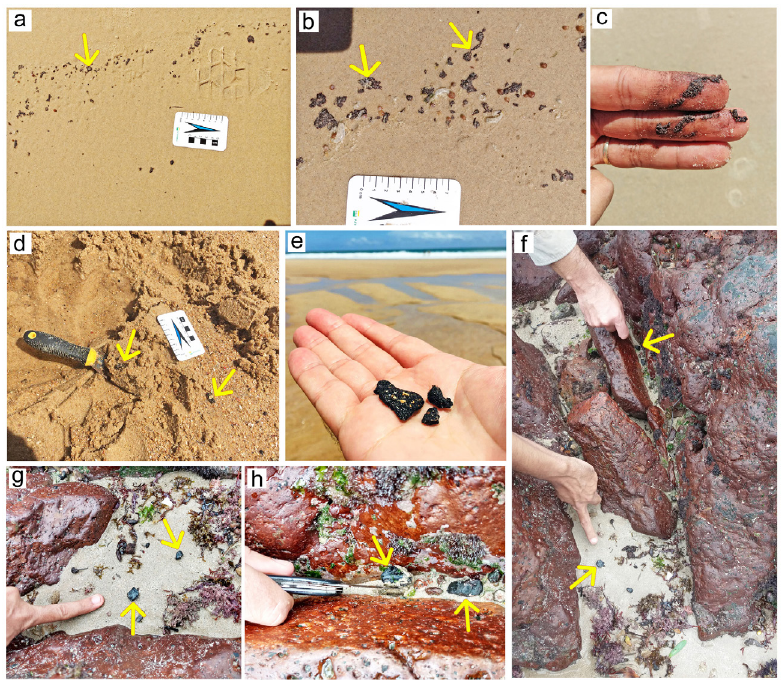
Figure 6. Beached tar balls and residue found on the studied beaches. 6a to 6c) Tar residues ranging from 5 to 30 mm in size found in the surf zone of Paiva Beach, January 2021. The isolated tar fragments were washed up with biogenic fragments and presented a viscous consistency. 6d and 6E) Tar balls, 5 to 30 mm in diameter, found in the surf zone of Enseada Beach during low tide, January 2021. The material is solid and is mixed with siliciclastic and biogenic particles. 6f to 6h) Tar balls found in the bottom of a pool during low tide in the surf zone of Itapuama Beach, March 2021. The isolated tar fragments were found with biogenic detrital particles and trapped in natural fractures (6h). The locations where the tar residues were found are indicated in the photos of Figure